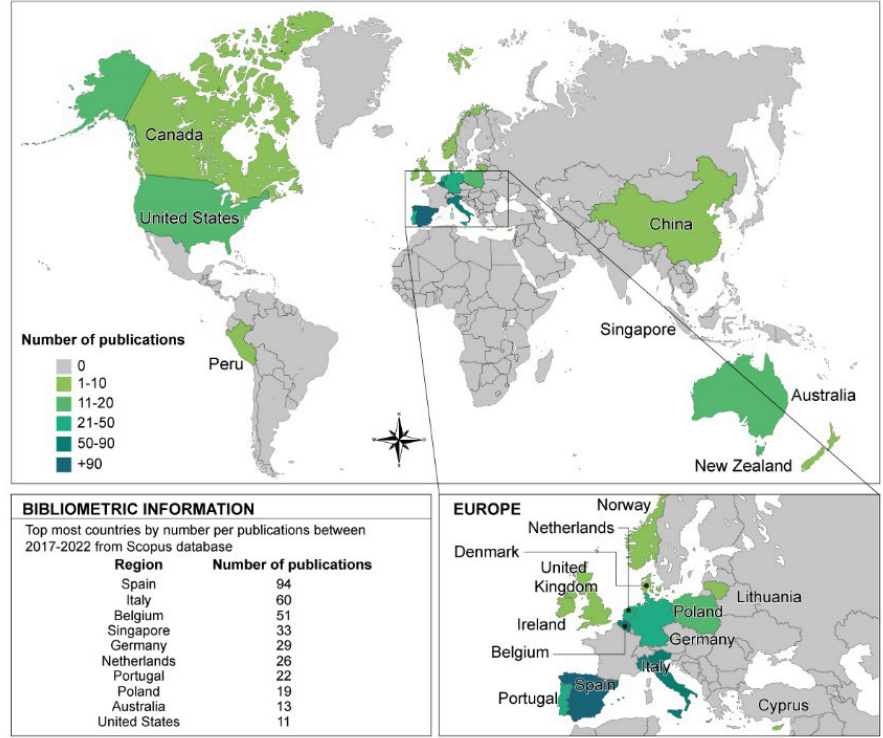
Figure 3. Geographical dynamics of most productive countries in the research of circular horticulture—own elaboration.